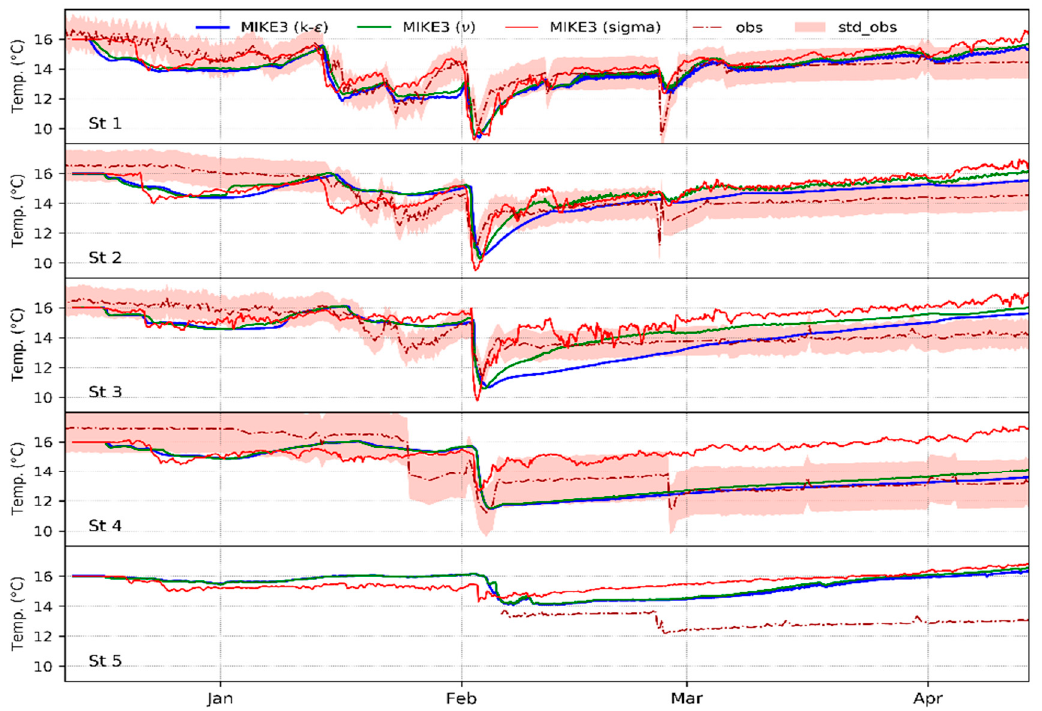
Figure 7. MIKE3-simulated water temperature using di ff erent discretizations and vertical mixing models: z-sigma with k- ε turbulence model (blue), z-sigma with constant eddy viscosity (green) and sigma k- ε turbulence model (red) versus measured values (dashed) at measurement depths of each station. Light red bands delineate the range of the ± standard deviation of the measured data. The red band at St5 is intentionally not indicated as the observed data of St5 represent a shorter period (from February) than other stations.